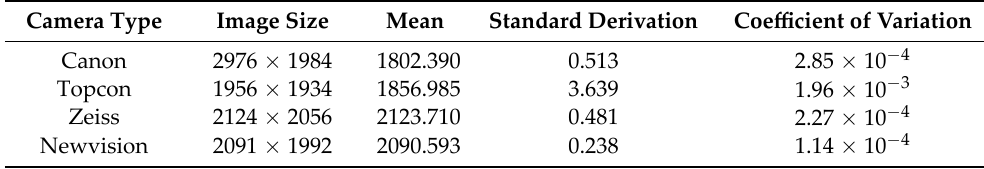
Table 4. Statistics of ROI diameter of cameras.